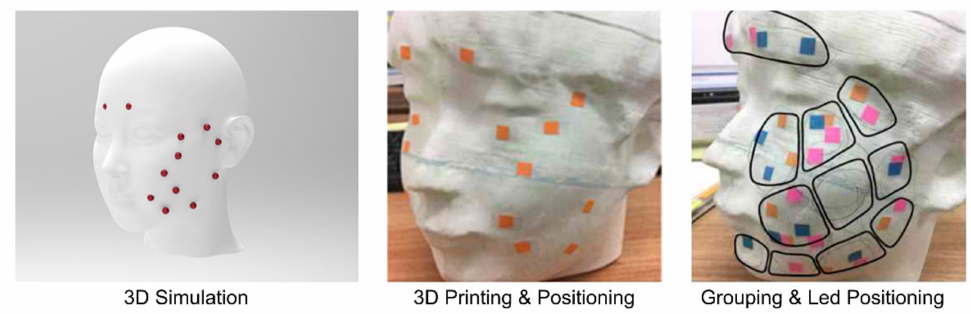
Figure 6. LED lighting module positioning.